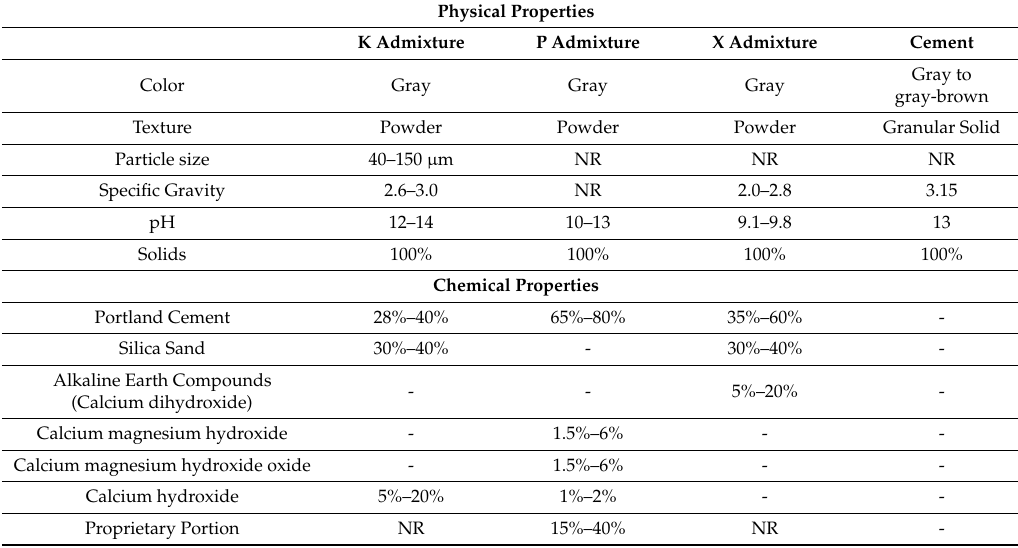
Table 1. Chemical and physical properties of crystalline waterproofing admixtures